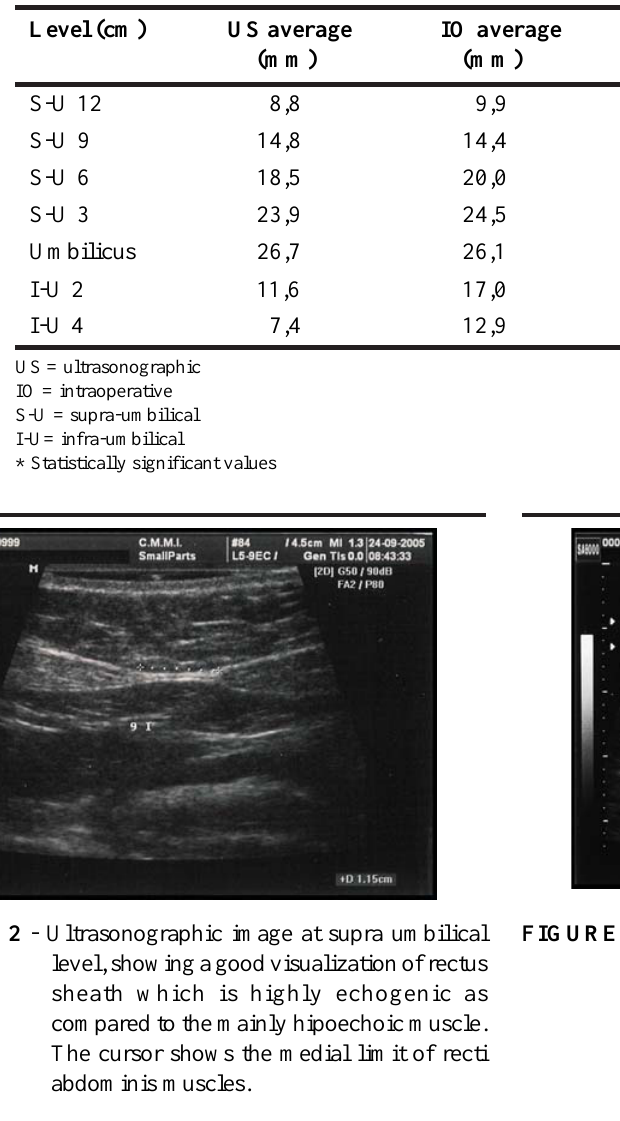
TABLE 2 - Average values for rectus diastasis, according to the level studied, having the umbilicus